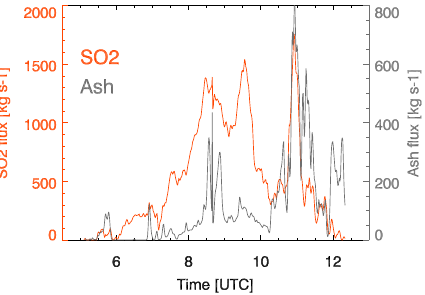
Figure 4. Sulfur dioxide (orange) and ash (grey) emissions (in kgs − 1 ) for 26 October 2013, estimated with the Aqua-MODIS in- verse